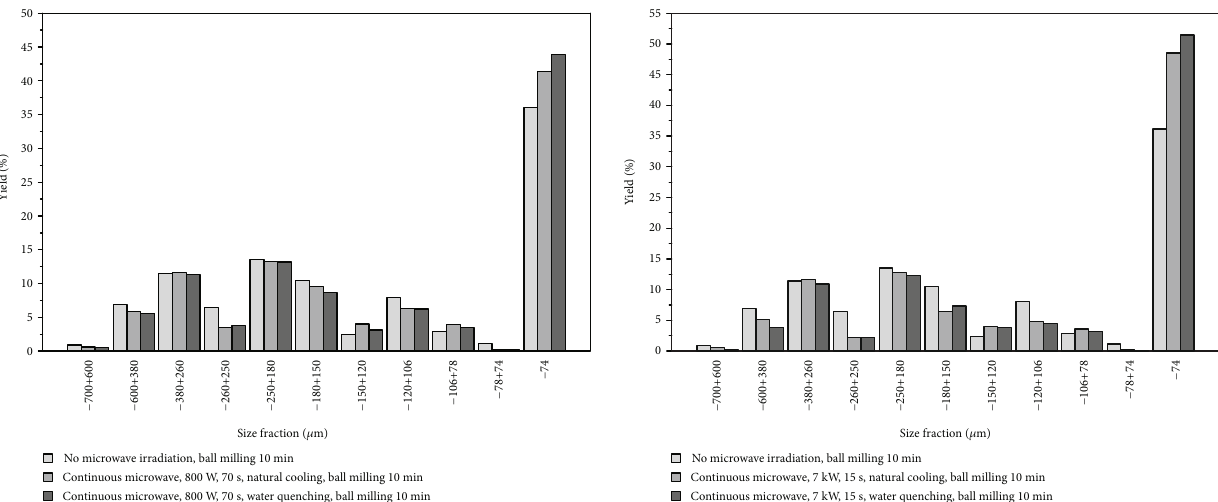
Figure 8: E ff ect of cooling method on the size fraction distribution of grinding products after continuous microwave